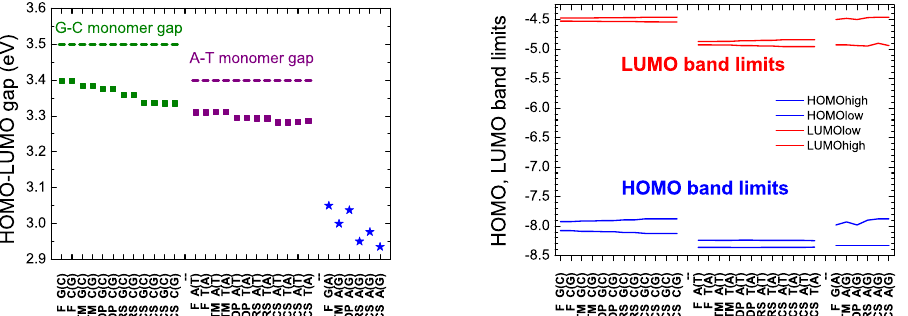
Figure 5. Energy gaps ( left ) as well as HOMO and LUMO band limits ( right ), at the large N limit, for all aperiodic polymers considered in this work. Squares: I Polymers, i.e., made of the same monomer. Blue stars: D Polymers, i.e., made of different monomers. The green (purple) dashed line shows the energy gap of the G-C (A-T) base pair. The notation of polymers is given in Table